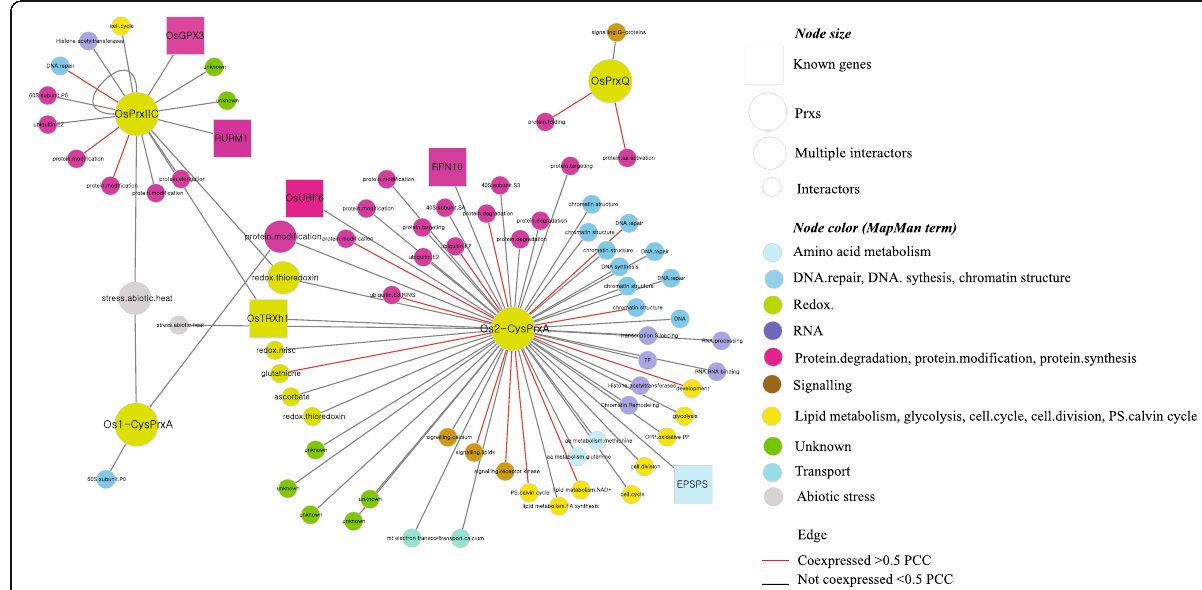
Fig. 6. Working model of rice PRXs for regulatory pathway using refined protein – protein interaction network. Predictions were made with RIV, which revealed interactions with 161 proteins mediated by four PRX proteins. Red edges ( lines ) indicate elements with PCC values >0.5; large rectangles in node, three interaction proteins with known functions identified from OGRO database; large circles , PRX family members; medium circles , interactors showing multiple interactions with PRX proteins. MapMan annotation is indicated by different node colors: bright green , redox class proteins, including peroxiredoxins and thioredoxins; pale blue , proteins involved in amino acid metabolism; yellow , proteins involved in cell cycle, lipid metabolism, photosynthesis, and development; blue , proteins involved in DNA synthesis and repair; pink , proteins involved in protein degradation and post-translational modification; purple , proteins involved with RNA, mostly transcriptional regulators; brown , signaling proteins; gray , abiotic stress proteins; light blue , transporter class proteins; green , proteins with unknown functions (see Additional file 11: Table